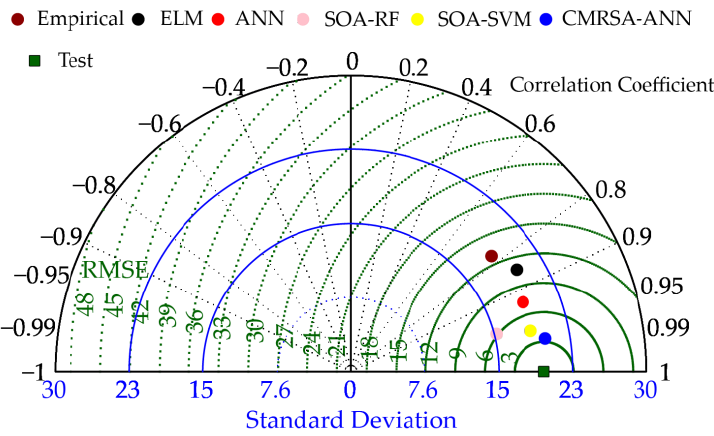
Figure 10. Performance comparison between prediction models using a Taylor diagram.